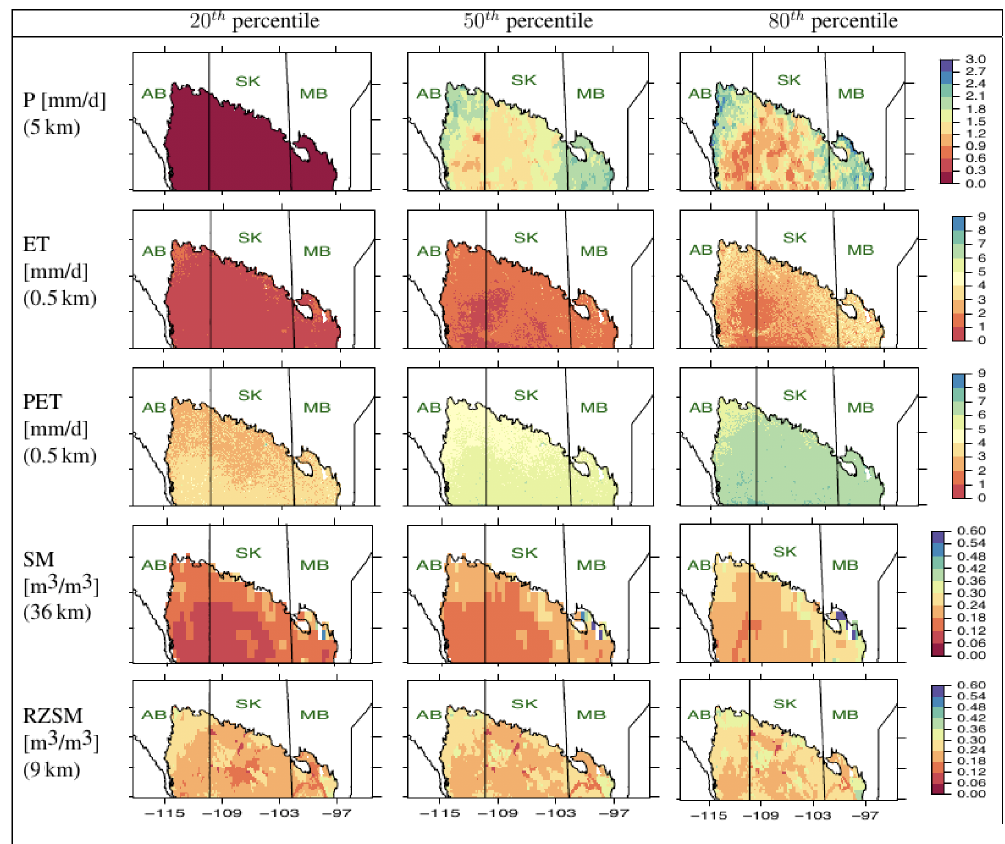
Figure 3. Spatial patterns of variables used for the CPE. Data collected from 2015 to 2020 for the agricultural months (April–October). AB is Alberta, SK is Saskatchewan, and MB is